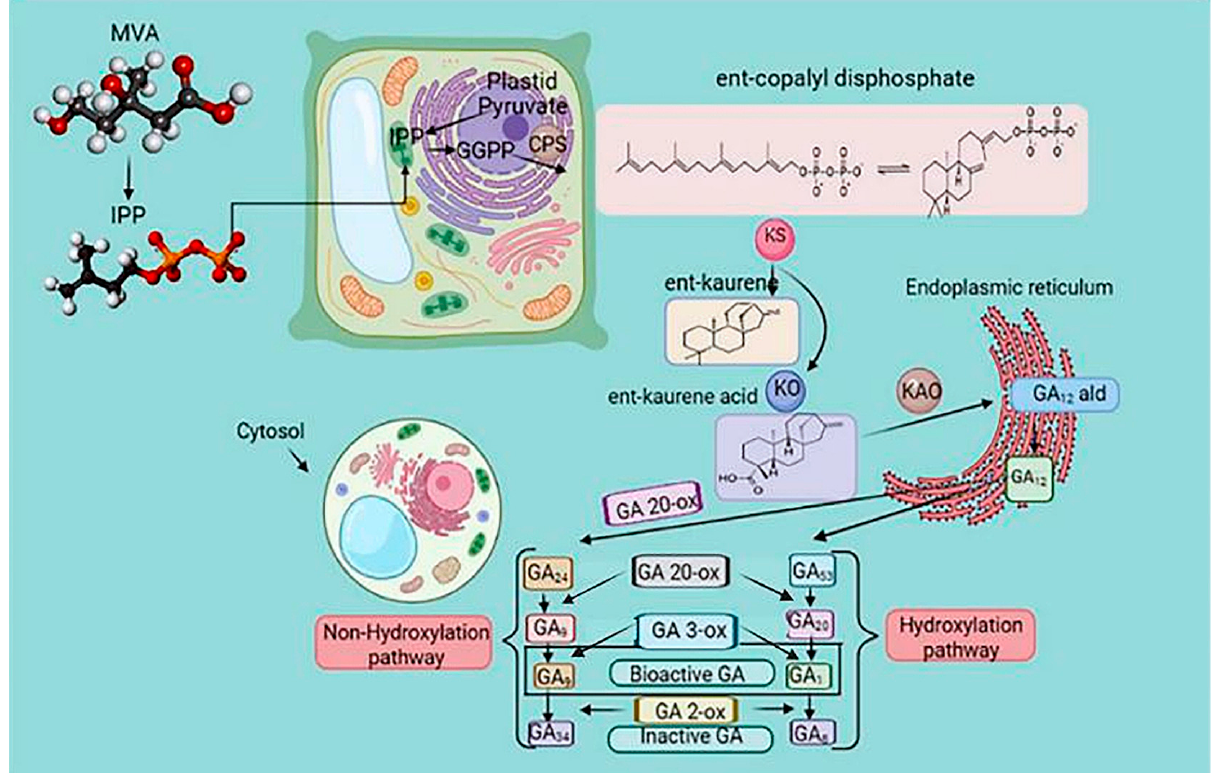
Figure 4. The gibberellin biosynthesis pathway in higher plants. The cellular location of metabolites in plastids is the endoplasmic reticulum and cytoplasm. Methylerythritol phosphate (MEP) and mevalonic acid (MVA) pathways regulate the biosynthesis of gibberellic acid (GA). Ent-copalyl diphosphate synthase (CPS) catalyzed the conversion of geranylgeranyl diphosphate (GGPP) to the endogen ent-kaurene and ent-kaurene synthase (KS), which is the precursor of GA. The biosynthesis of GA is a process of various enzymatic reactions, and the oxidation reaction of GAox is the critical enzymatic reaction. Arrows indicate a cascade reaction catalyzed by an enzyme. Gibberellin Biosynthetic Pathway in Higher Plants. GGPP, trans-genanylgeranyldiphosphate; CDP, ent-copalyl diphosphate; CPS, CDP synthase; KS, ent-kaurene synthase; KO, ent-kaurene oxidase; KAO, ent-kaurenoic acid oxidase; GA20ox, GA 20-oxidase; and GA3ox, GA